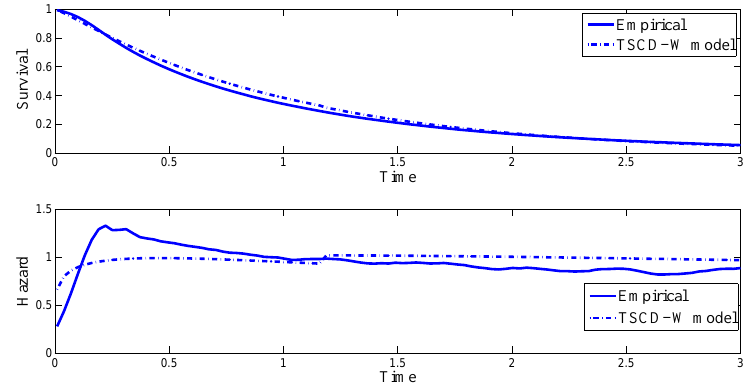
Figure 10. Top Panel: conditional survival function of the TSCD-W model for the Boeing durations and its empirical survival function. Bottom Panel: the corresponding conditional hazard function for the Boeing durations data and its empirical hazard